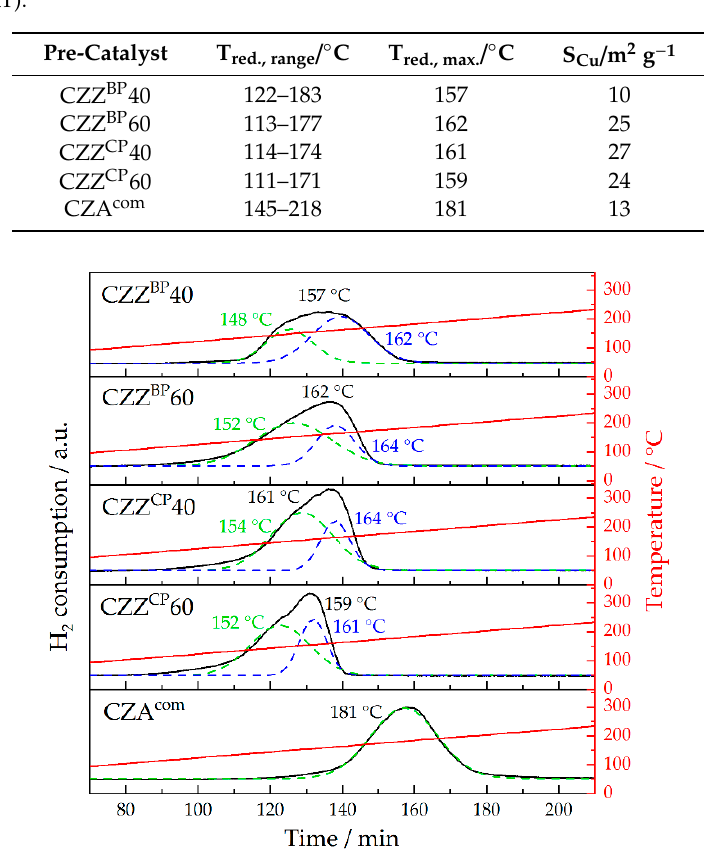
Figure 5. H 2 -TPR profiles of the calcined CZZ pre-catalysts and CZA com (H 2 -TPR: 5% H 2 / Ar, 1 K min − 1 , Figure 5. H 2 ‐ TPR profiles of the calcined CZZ pre ‐ catalysts and CZA com (H 2 ‐ TPR: 5% H 2 /Ar, 1 K min ‐ 1 , RT–300 ◦ RT–300 °C).